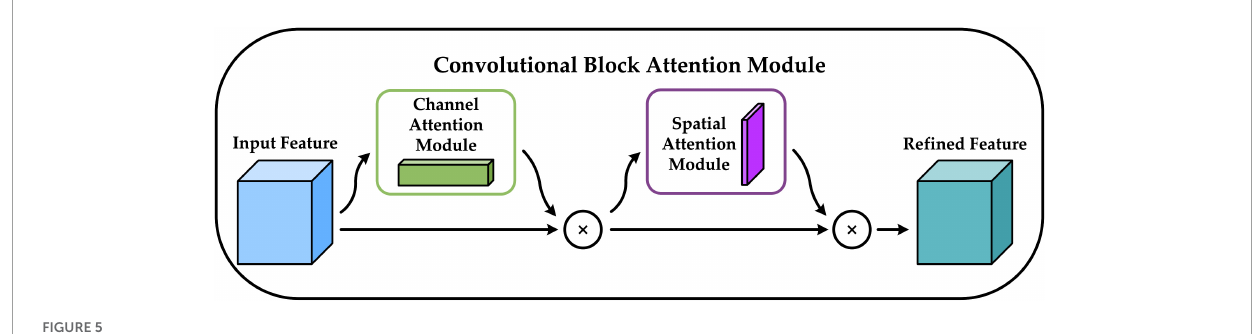
FIGURE5 Convolutional block attention module (CBAM) network structure.